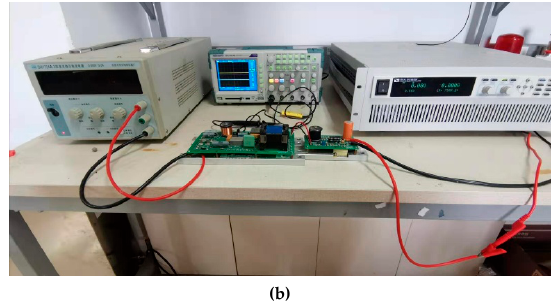
Figure 13. Test of CC–CV converter: (a) Principle prototype of CC–CV converter; (b) construction of laboratory test environment.